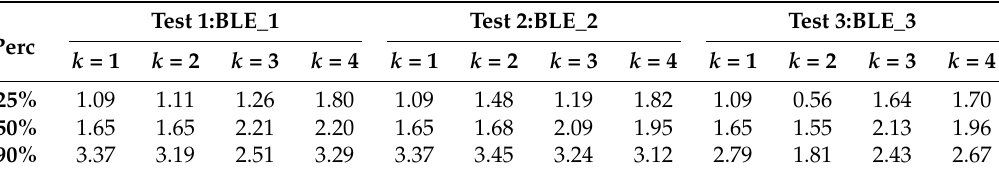
Table 8. Precision of Tests 1, 2 and 3. 42 reference points.